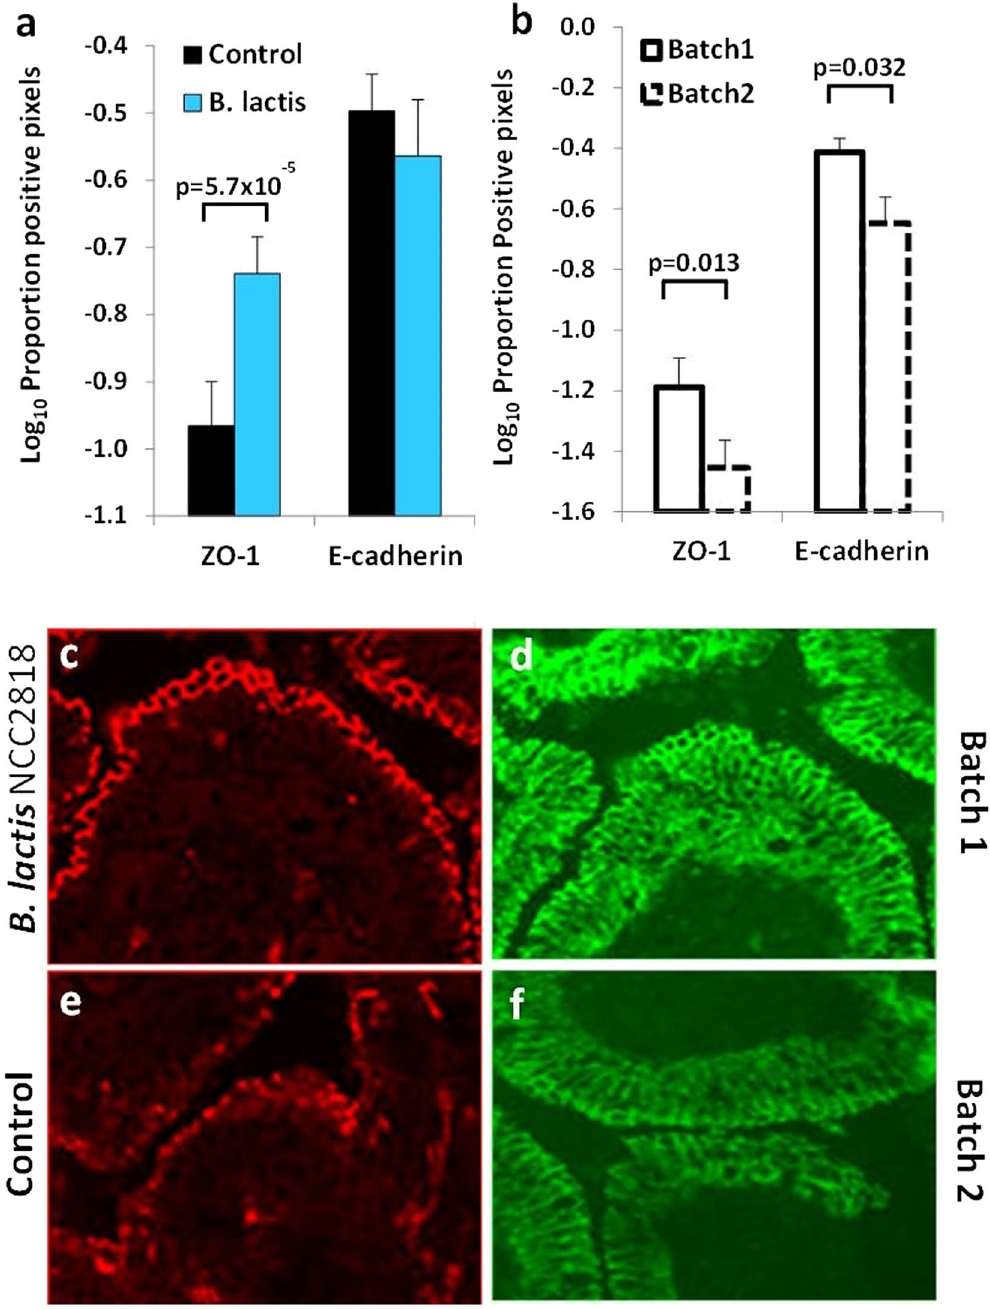
Figure 1. Expression of tight-cell junction proteins is increased by B. lactis NCC2818 supplementation and by batch. Quantitative immunohistology of ZO-1 and E-cadherin staining in jejunal epithelium in response to treatment ( a ) or related to batch ( b ). Representative images of ZO-1 staining (red) in the treatment group ( c ) and control group ( e ), and E-cadherin staining (green) in batch 1 ( d ) and batch 2 ( f ) in the villus tip. n = 6; Error Bars =